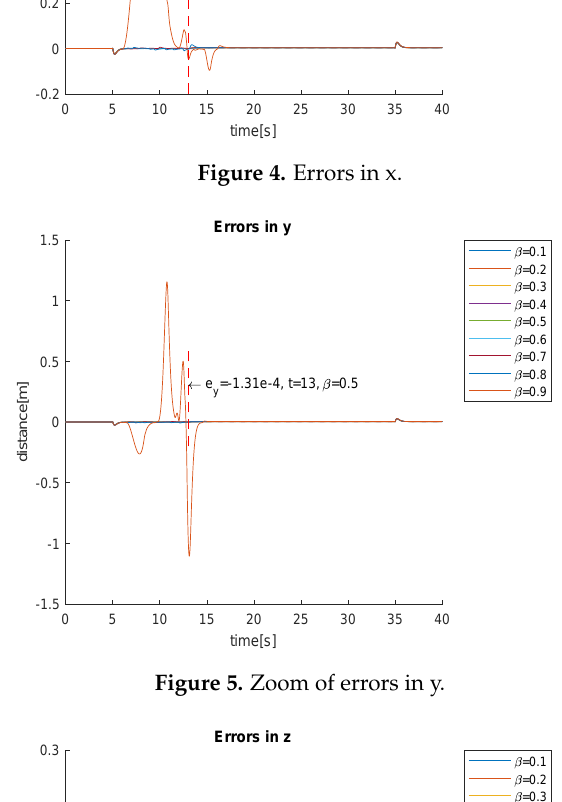
Figure 4. Errors in x.